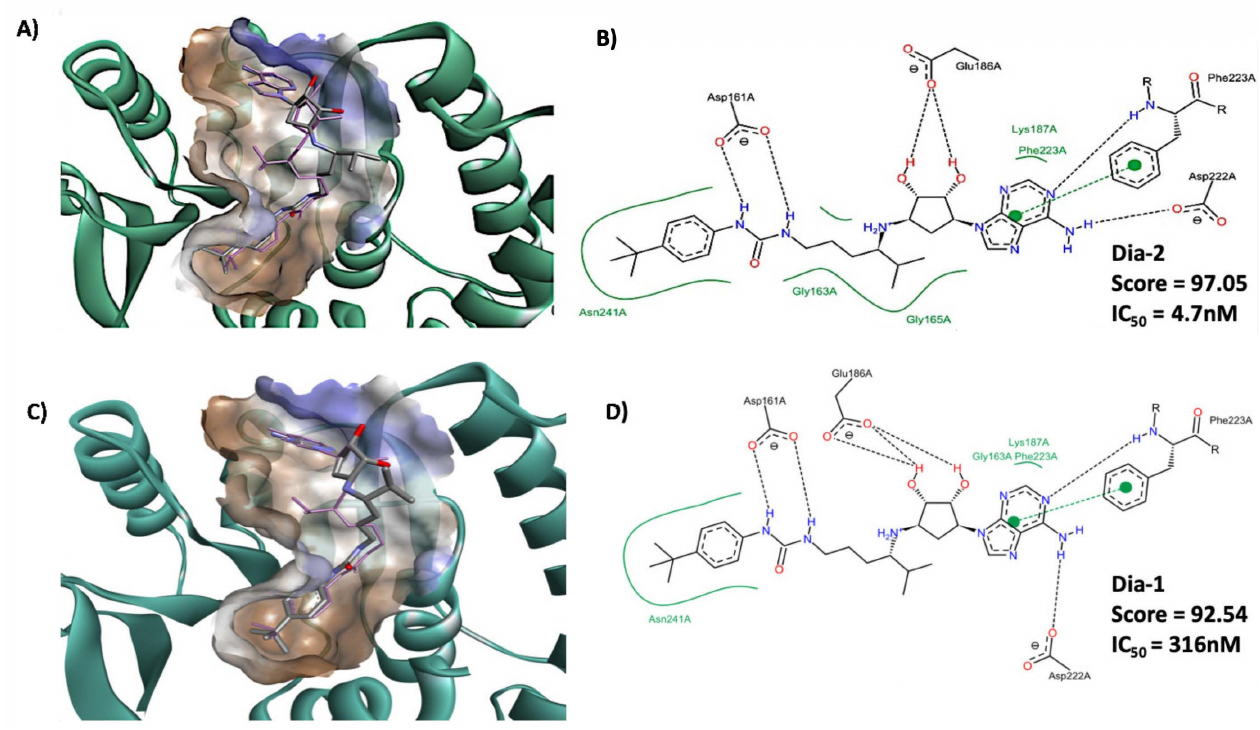
Figure 3. Representation of the docking of Dia1 and Dia2 using the crystal structure of DOT1L with EPZ-4777 1 (PBD 4ER3). ( A ) Representation of compound Dia2 inside the catalytic pocket of human DOT1L, the hydrophobicity surface being represented by a cloud going from blue (hydrophilic zone) to brown (more hydrophobic zone) magenta sticks represents co-crystal ligand. ( B ) Representation of the interacting amino acid of DOT1L catalytic pocket with Dia2 . ( C ) Representation of Dia1 inside the catalytic pocket of human DOT1L, the hydrophobicity surface being represented by a cloud going from blue (hydrophilic zone) to brown (more hydrophobic zone). Magenta sticks represent co-crystal ligand. ( D ) Representation of the interacting amino acids of DOT1L catalytic pocket with